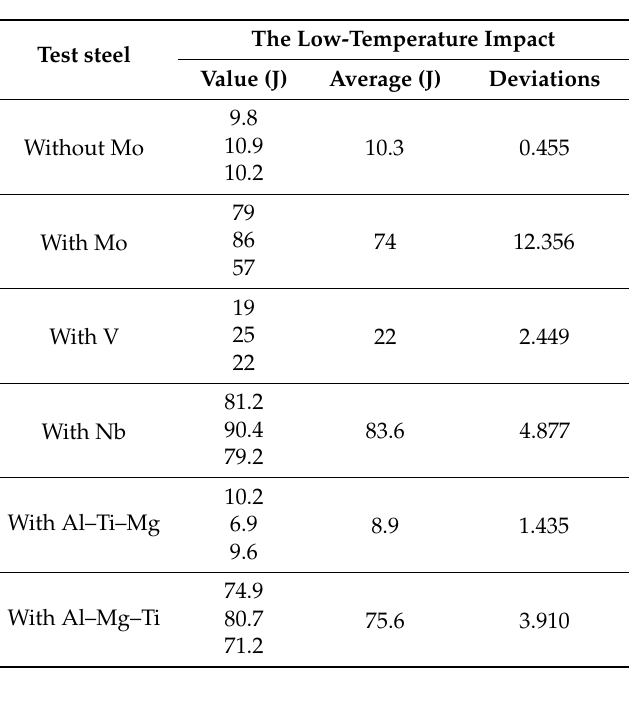
Table 2. The low-temperature impact of test steel (J).